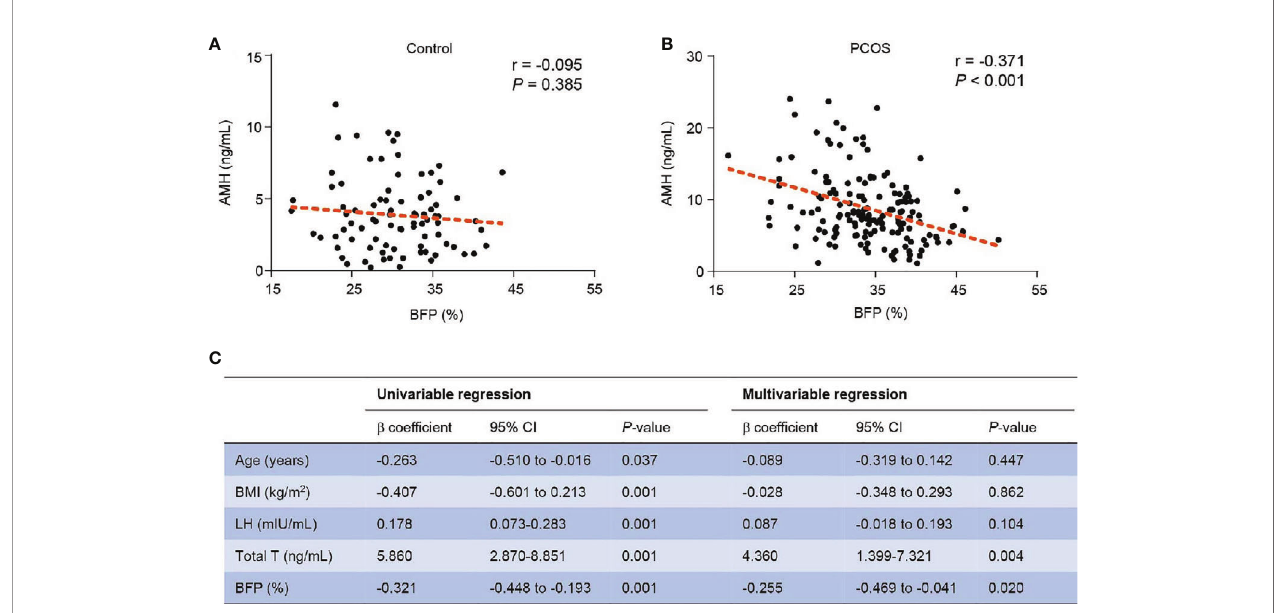
FIGURE 2 | Relationship of BFP with AMH. (A) Relationship of BFP with AMH in the control group. (B) Relationship of BFP with AMH in the PCOS group. (C) Linear regression of BFP with AMH in PCOS patients. PCOS, polycystic ovary syndrome; AMH, anti- Müllerian hormone; BMI, body mass index; LH, luteinizing hormone; Total T, total testosterone; BFP, body fat percentage; CI, con fi dence interval.